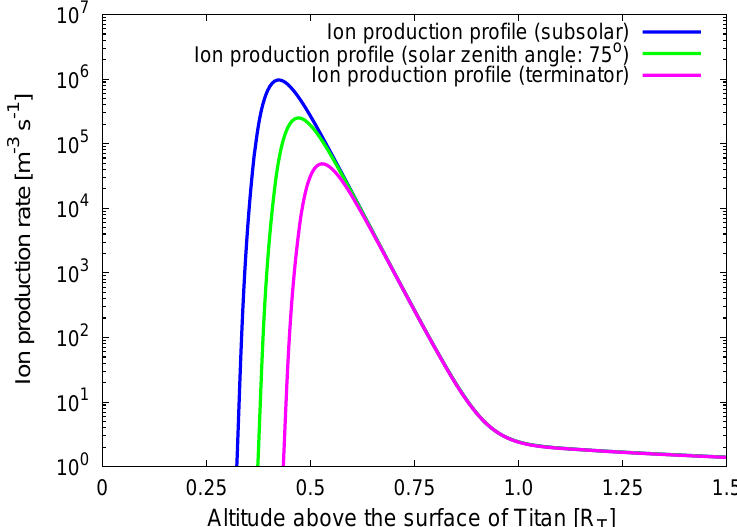
Fig. 2. Production of molecular nitrogen as a function of altitude above the surface. The figure displays the production rate q ν at the subsolar point (green line), at a solar zenith angle of χ ν = 75 ◦ (green line) and at the terminator (magenta line). As can also be seen in Fig. 3, the altitude of the production maximum increases when moving from the subsolar point to the terminator. In contrast to this, the value of maximum production diminishes for large solar zenith